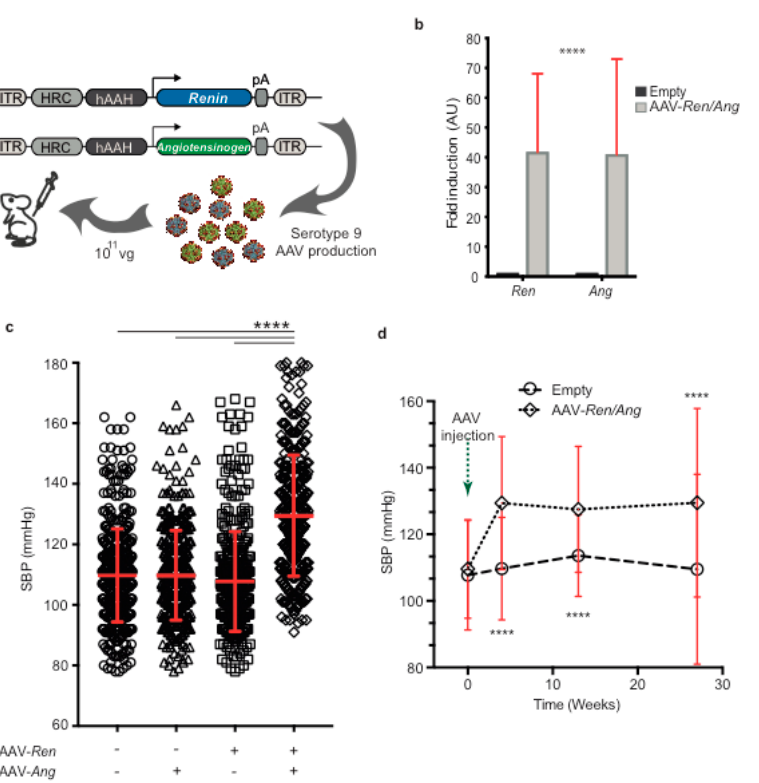
Figure 1. A single injection of AAV- Ren/Ang viruses increases systolic blood pressure (SBP). ( a ) Plas- mids encoding the expression of hRenin ( Ren ) and hAngiotensinogen ( Ang ). The plasmids were intro- duced into serotype 9 adeno-associated viruses (AAV) and injected via the tail vein. ( b ) Liver mRNA expression of AAV-delivered exogenous Ren and Ang genes in C57BL6/J mice. ( c ) C57BL6/J mice were given either a single injection of AAV- Ren or AAV- Ang or a combined injection with both viruses (5 × 10 10 vector genomes/animal, n = 10). Co-injection induced a sustained maximal mean SBP increase of ≈ 20 mmHg. Mean SBP was calculated from measurements from weeks 8 to 12. Data are mean ± SEM. **** p < 0.0001 versus empty vector transduced control group. ( d ) Evolution of tail- cuff measured SBP after AAV- Ren/Ang or AAV-empty vector injection. **** p < 0.0001, 2-way re- peated-measures ANOVA (n = 10–25 per group). ITR, inverted terminal repeats; HCR-hAAH, hu- man antitrypsin gene promoter with an ApoE gene enhancer; pA, poly-A sequence.